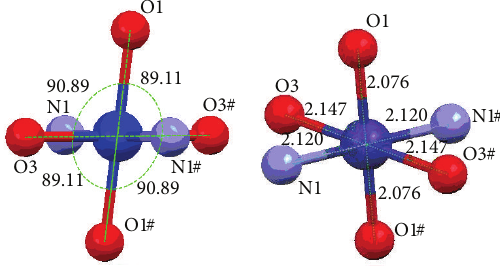
Figure 2: Coordination environment of the Co(II) ion.